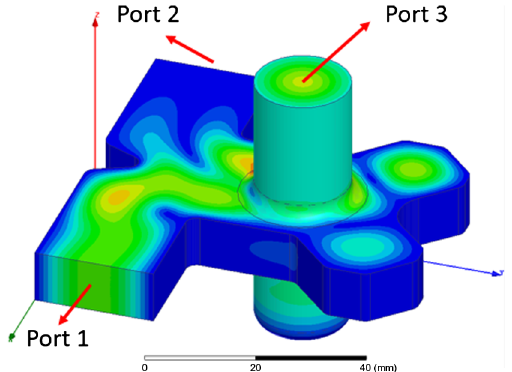
FIG. 11. Geometry and E-field distribution at 1 W input power injected from port